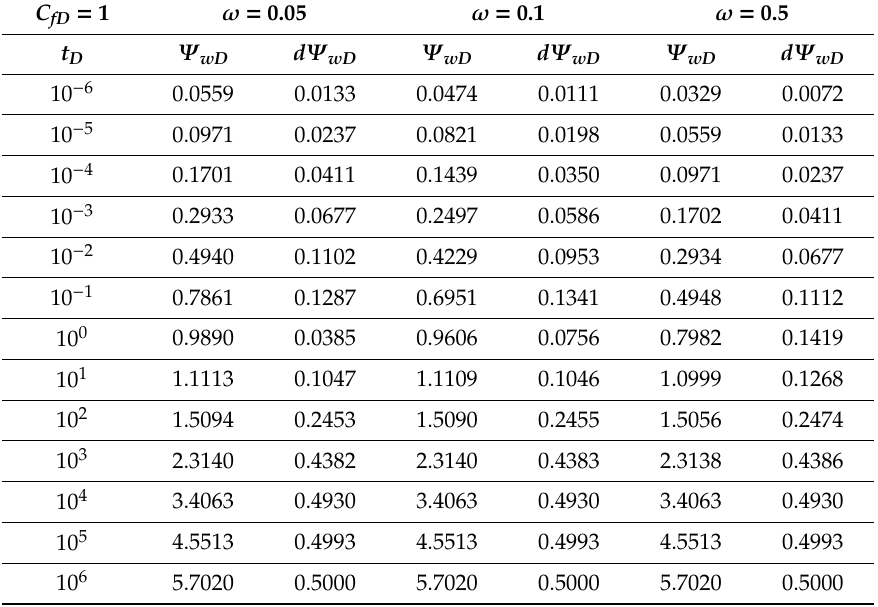
Table 1. The pseudo-pressure and pseudo-pressure derivative data for different storability ratio.